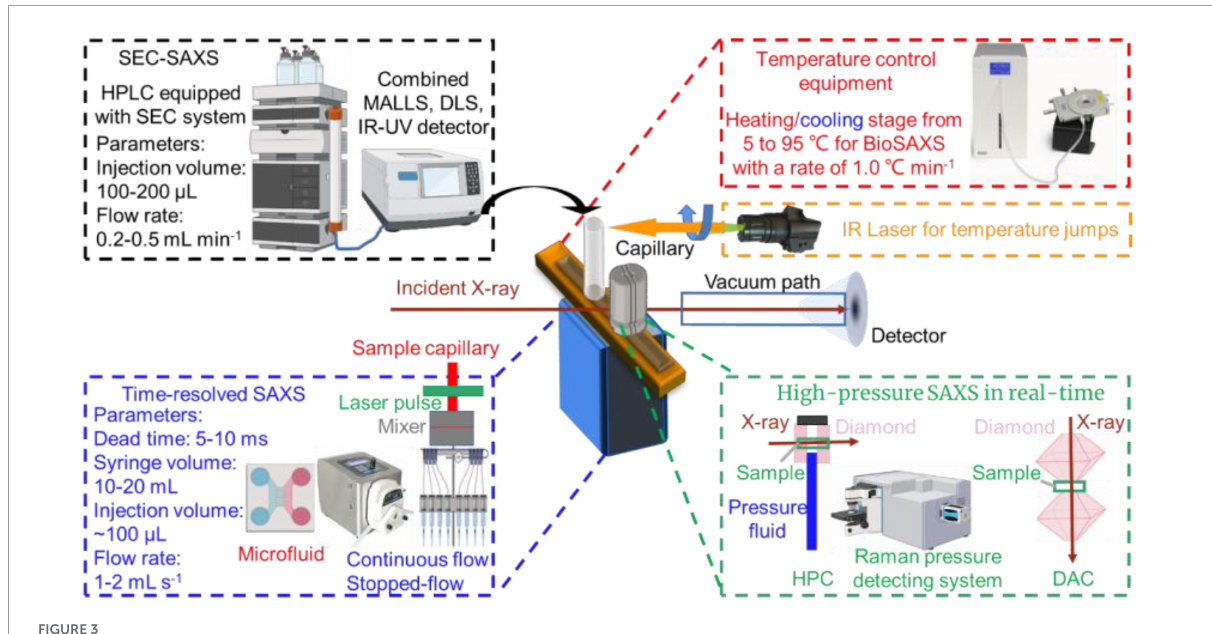
FIGURE3 In situ capabilities of small-angle X-ray scattering